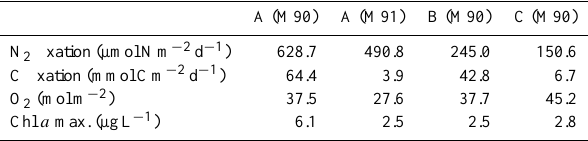
Table 1. Vertically integrated biogeochemical parameters of the three eddies in the ETSP during the M90 and M91 cruises. N 2 and C fixation rates as well as O 2 , concentrations are expressed as in- tegrated concentrations or abundances over the upper 500m of the water column (data taken from the eddy centers). Chl a concentra- tions are taken from Stramma et al. (2013) and represent maximum concentrations in the subsurface